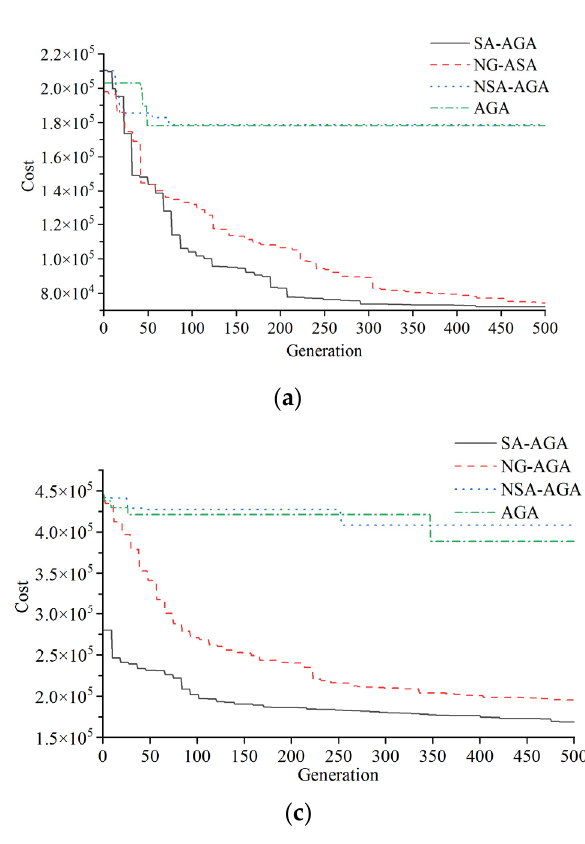
Figure 11. The convergence curve of the SA–AGA, NG–AGA, NSA–AGA and AGA. ( a ) Number of vessels is 20; ( b ) number of vessels is 30; ( c ) number of vessels is 40. (Source: compiled by authors).